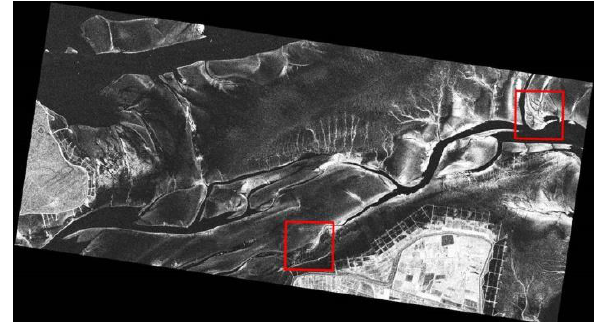
Figure 5. TerraSAR-X image of the area of interest, north of Pellworm and east of Hooge. The image was acquired on 12 December 2012. The red squares denote the same locations as in Figure 3. © DLR 2012.